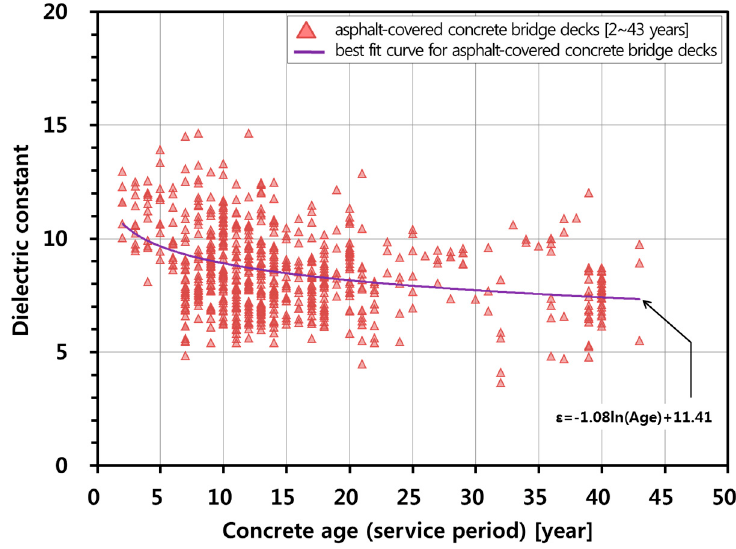
Figure 5. Variation of dielectric constant of concrete in asphalt-covered bridge deck with concrete age (service year).